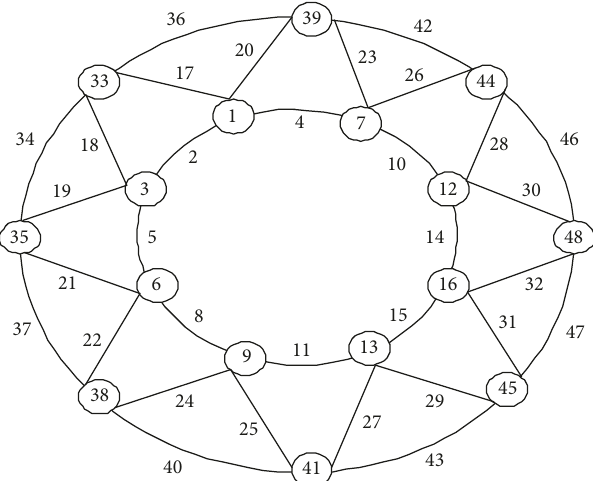
Figure 4: The super mean labeling for total graph of cycle on 8 vertices, 𝑇(𝐶 8 )